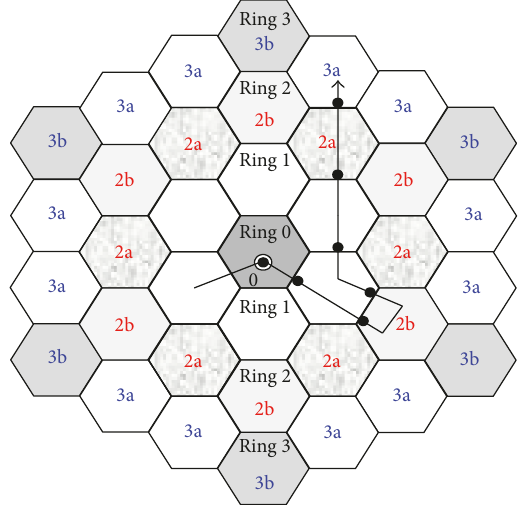
Figure 1: Location registration area and ring ( 𝐷 = 4 ) in hexagonal cell